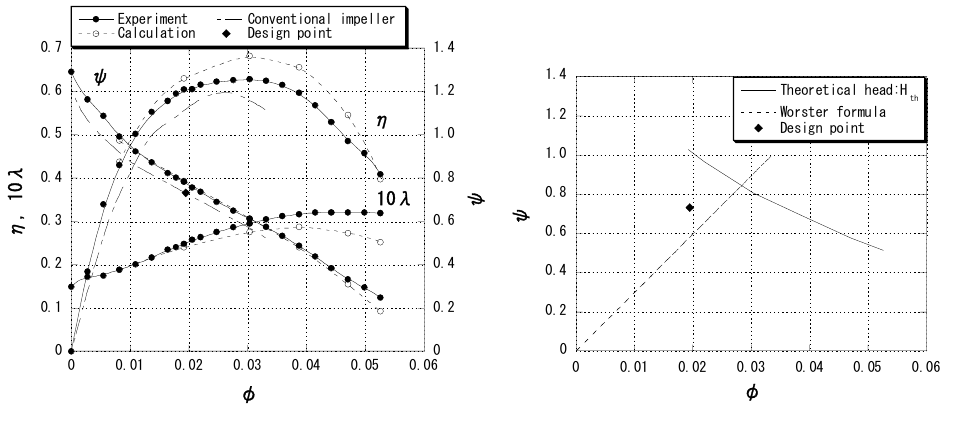
Fig. 7 Performance curves Fig. 8 Theoretical head and volute